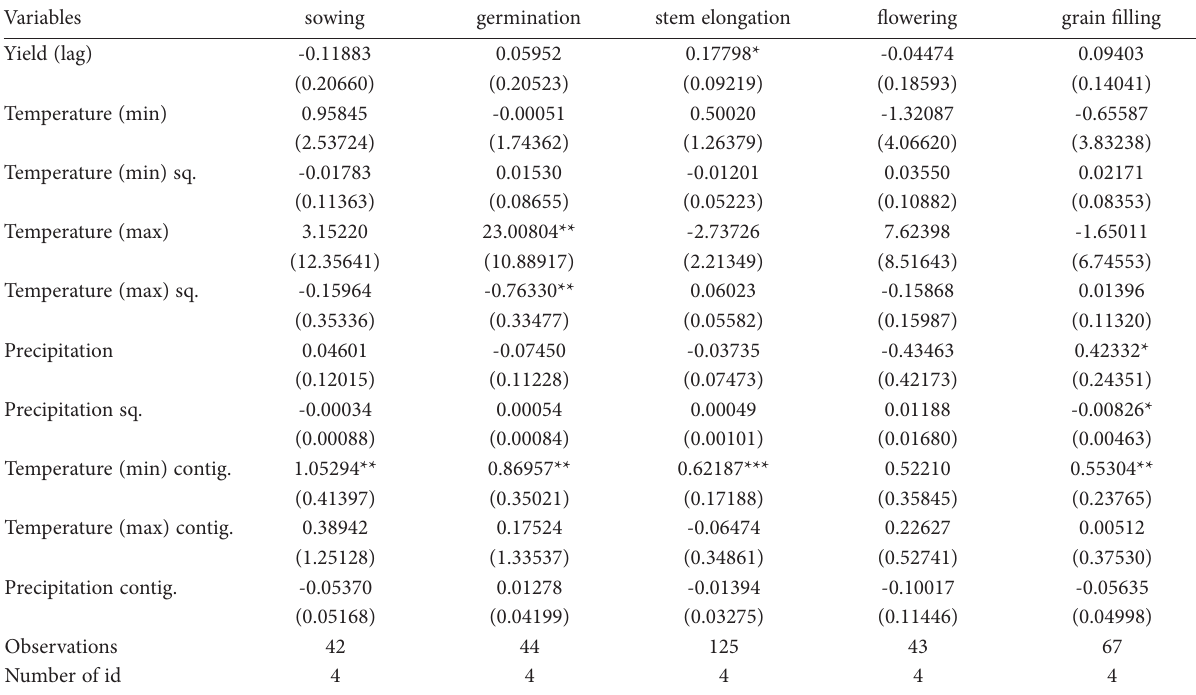
Table 5. Effects of weather variables on yield by phase.